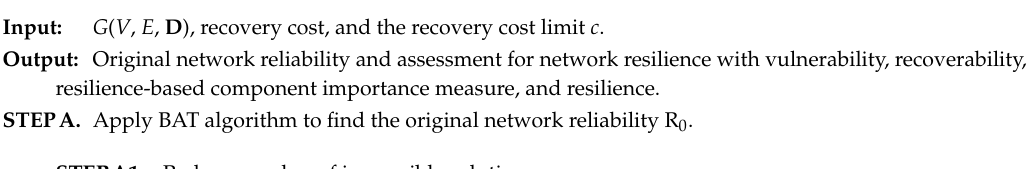
Algorithm 3: Procedure of the BAT-based Resilience Assessment: to evaluate the binary-state network